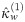
”Error-bar” plots of the Cohen’s kappa coefficient estimates (percent) for EXP2, bibliometric vs peer review ratings.The confidence intervals are at 95% confidence level and estimates corresponding to κ^w(1), κ^w(2) and κ^w(3) are in red, green and blue, respectively.